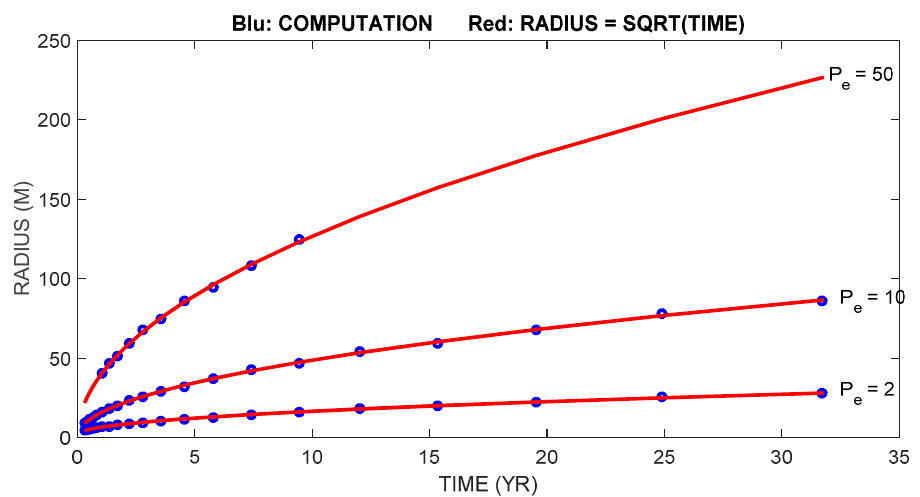
Figure 29. For Peclet number P e = r 0 φ v 0 /D applied to a wellbore-centric heat exchange flow system, an EGS wellbore couplet requires a crustal volume of order given by the length of the wellbores and by the radial offset of the wellbore couplet (vertical axis) for heat supply over a given period of time (horizontal axis).